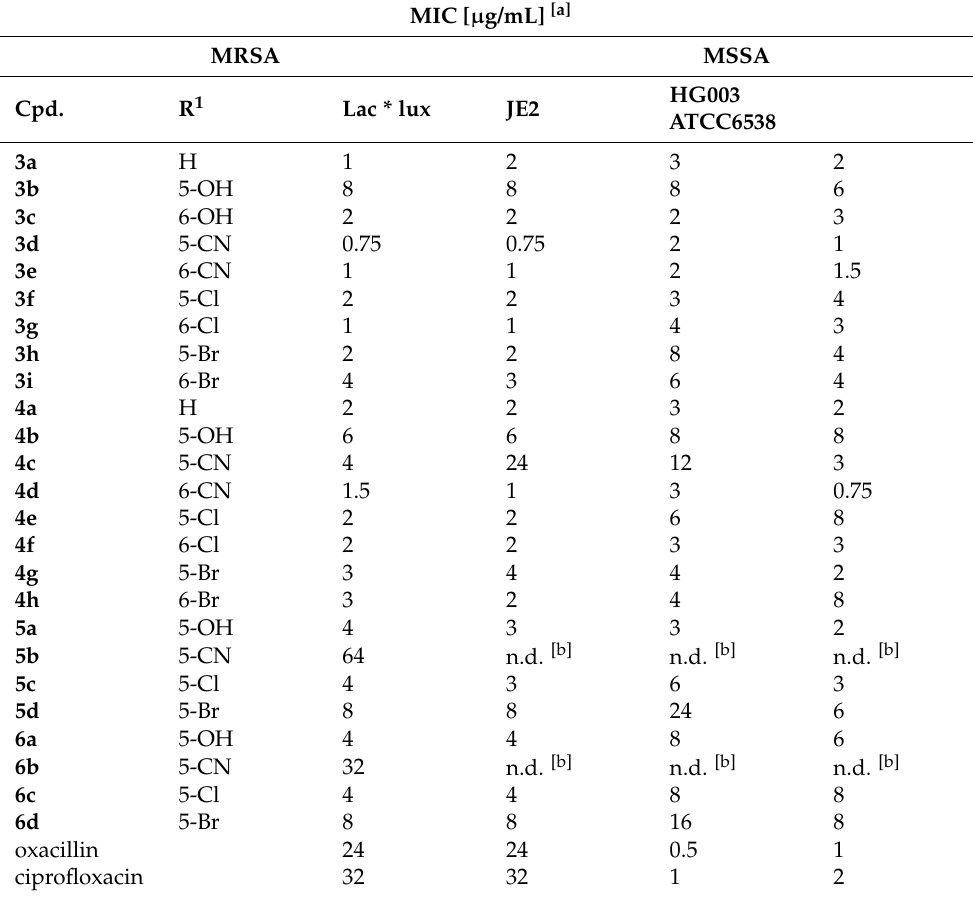
Table 1. MRSA and MSSA inhibition data of target compound classes 3 – 6 expressed as MIC